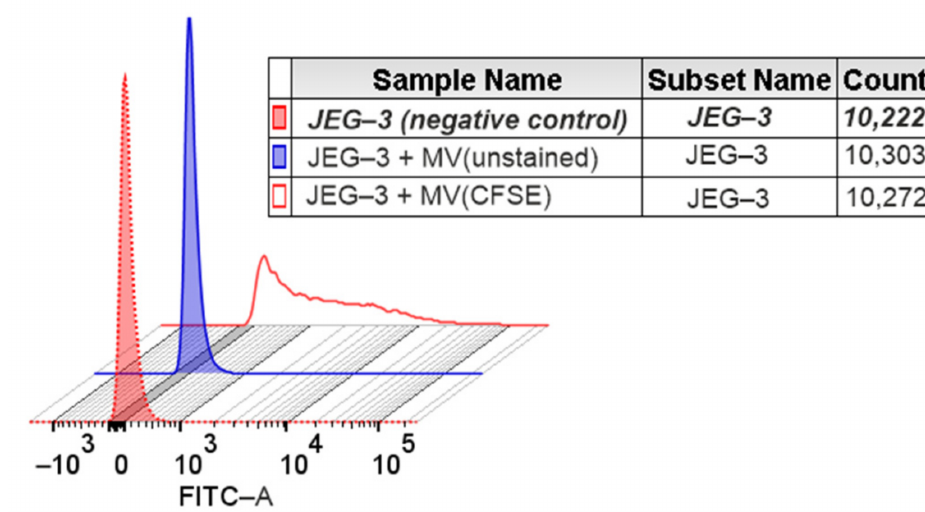
Figure 2. Histogram for distribution of JEG-3 cells incubated in the presence of microvesicles (MVs) formed by NK-92 cells, in FITC channel: (red) intact JEG-3 cells (negative control); (blue) JEG-3 cells treated with MVs obtained from intact (unstained) NK cells; (colorless) JEG-3 cells treated with MVs derived from NK cells pretreated with CFSE at a concentration of 50 µ M; n =